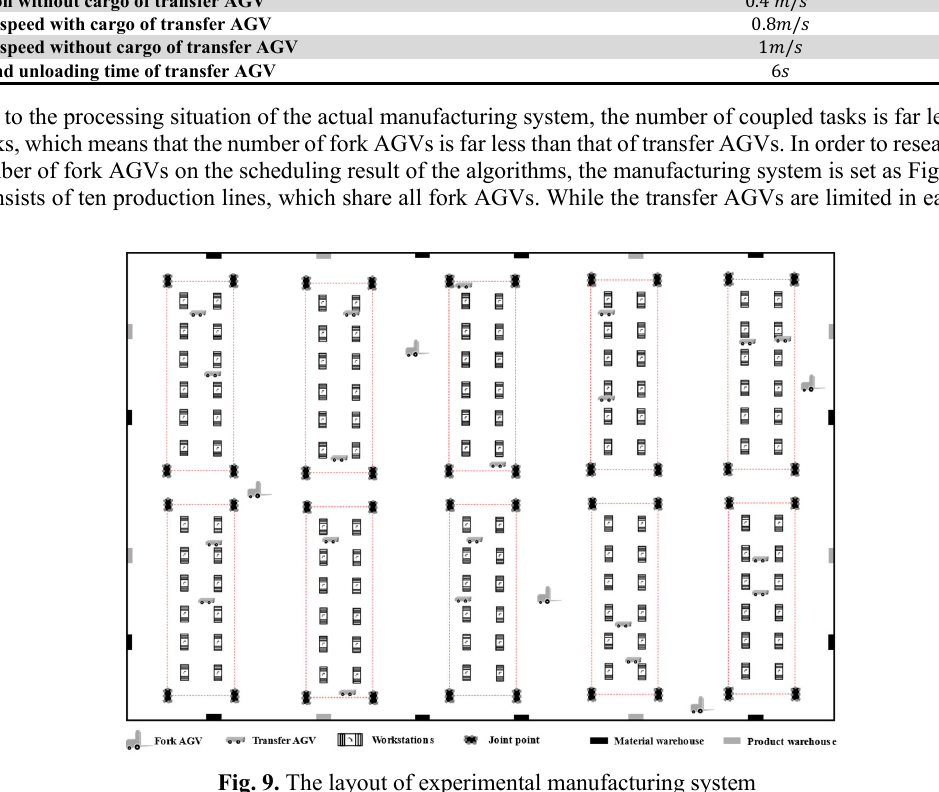
Fig. 9. The layout of experimental manufacturing